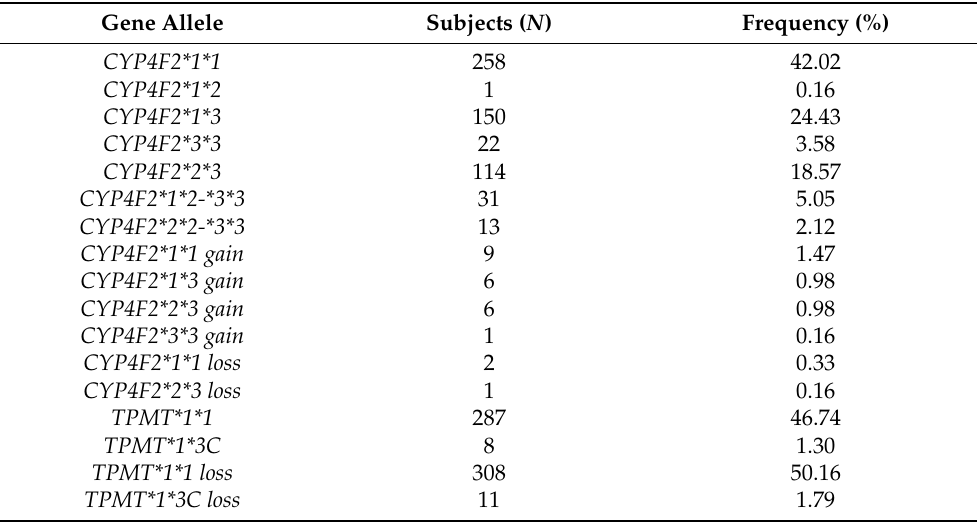
Table 3. Copy number variation combined with single nucleotide variations in Koreans ( N =